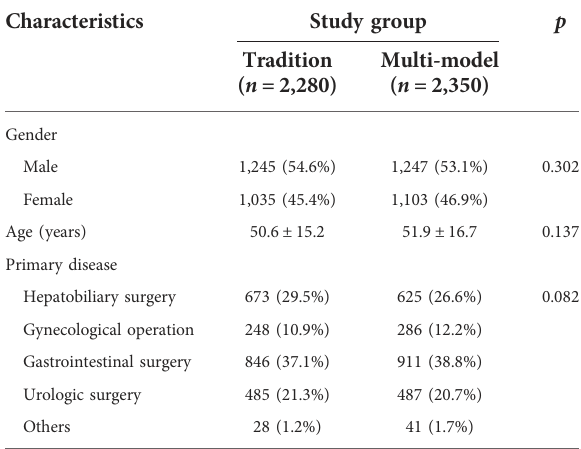
TABLE 1 Demographic and clinical characteristics of patients under traditional process group and multimodal practice group.